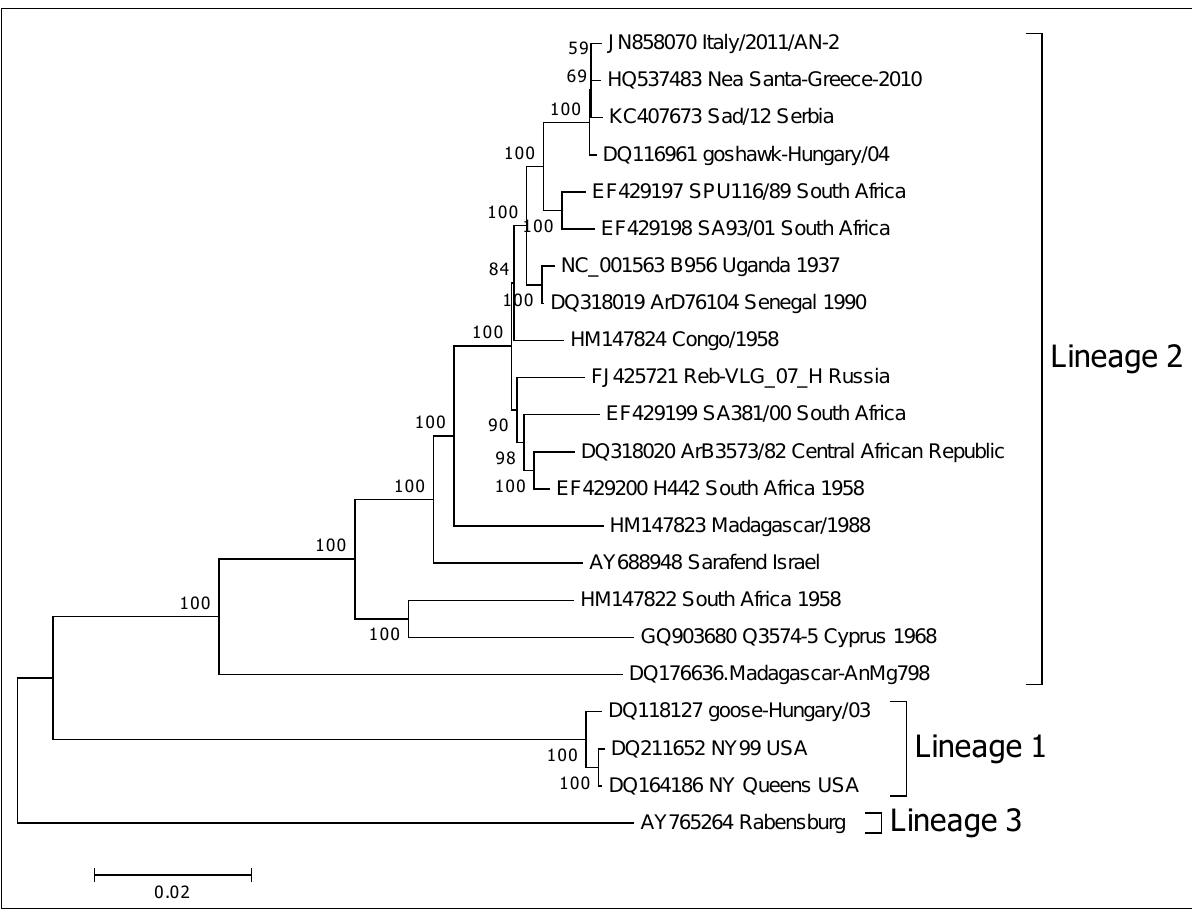
Figure 1. Neighbor-Joining phylogenetic tree (1,000 replicate trees, 10,278 positions in the final dataset) showing the clustering of the WNV strain Nea Santa-Greece-2010 into the WNV lineage 2. Evolutionary analyses were conducted in MEGA5